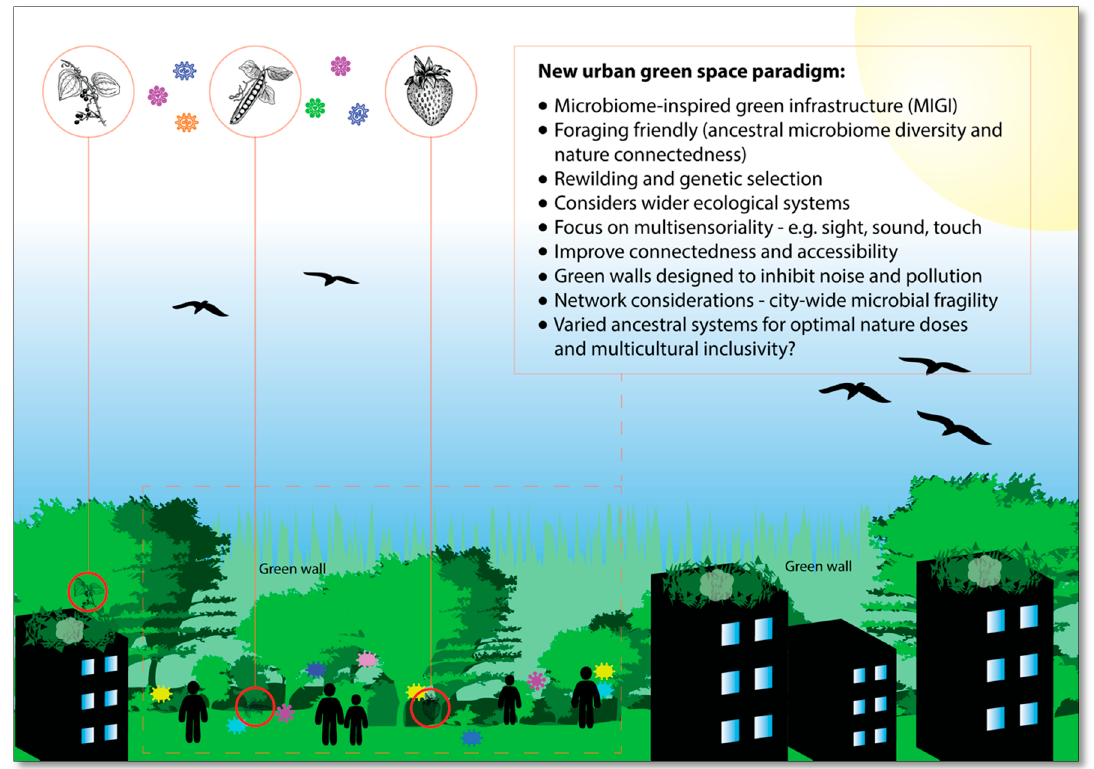
Figure 2. A vision for the future: microbiome-inspired green infrastructure (MIGI) and multisensorial, multiculturally inclusive, and foraging-friendly green spaces (created by the author).